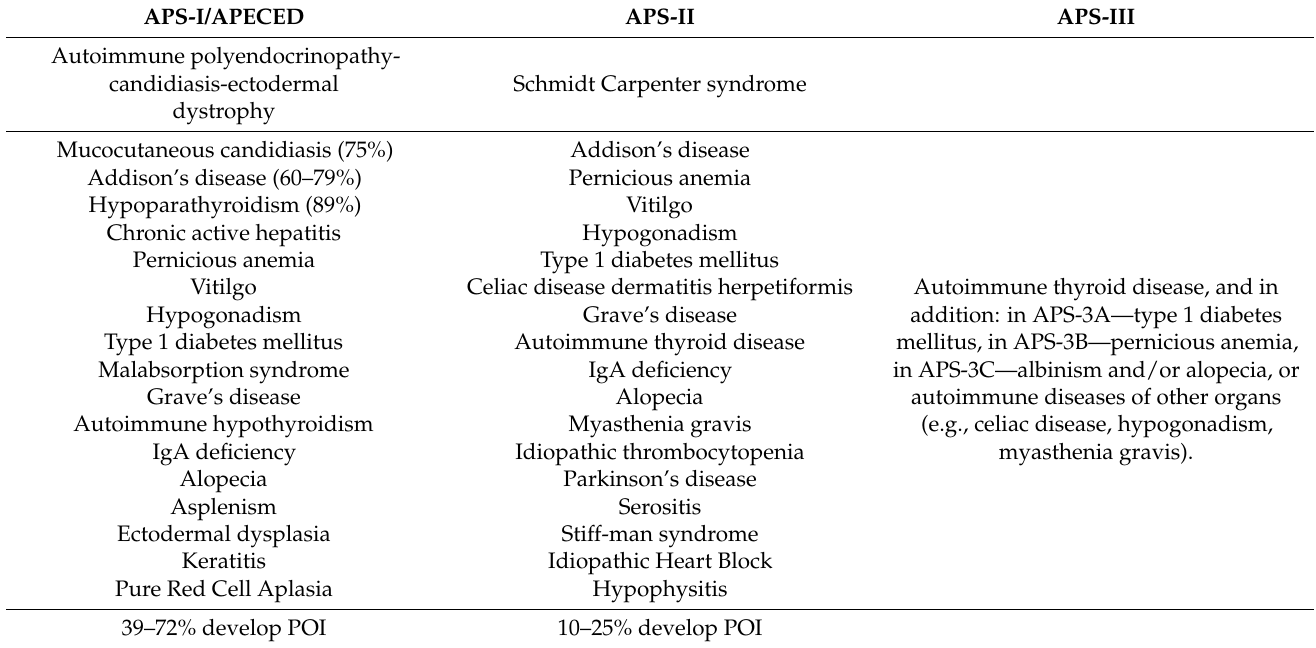
Table 2. Autoimmune polyendocrine syndromes (APS) associated with POI